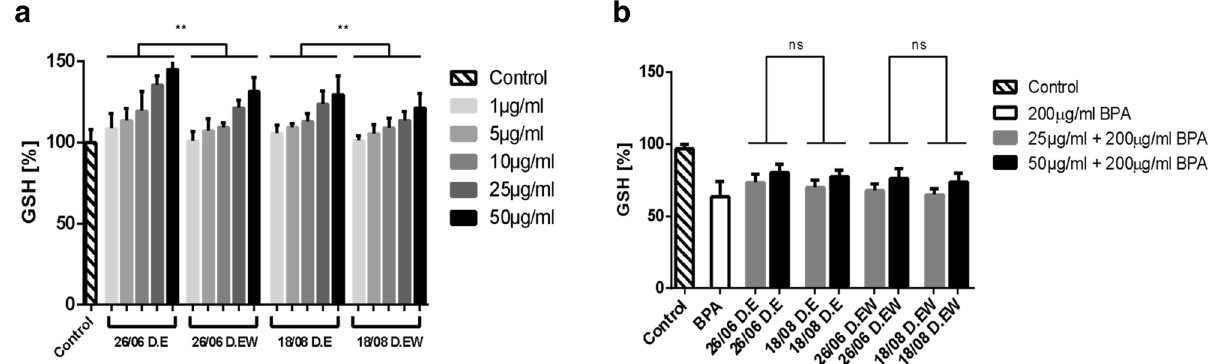
Figure 3. Effect of ethanol (D.E) and ethanol–water (D.EW) extracts of H. perforatum L. prepared from air- dried flowers on: (a) GSH level in human erythrocytes, (b) GSH depletion in human erythrocytes induced by 200 μg/mL BPA.